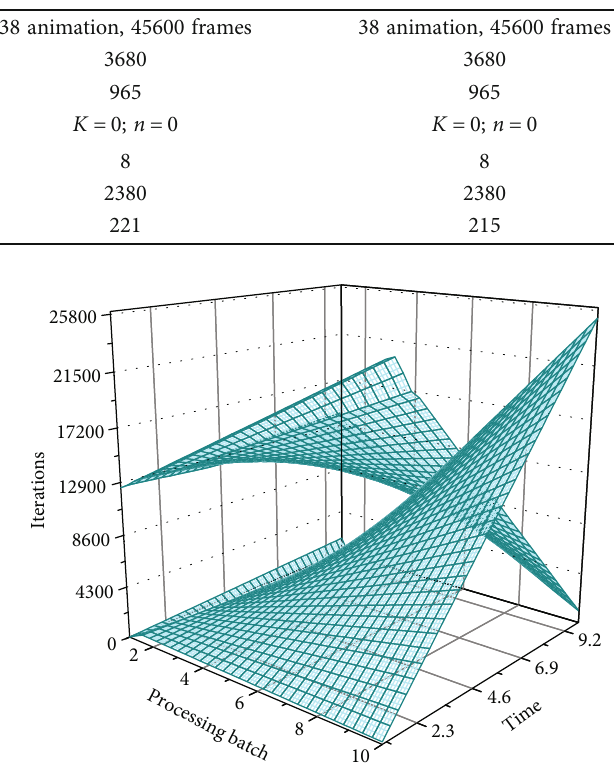
Figure 5: FluidsNet training iteration